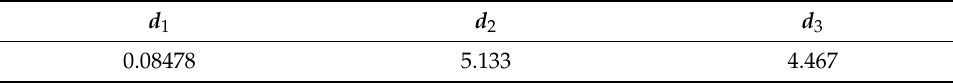
Table 5. Parameters used in the J–C fracture locus